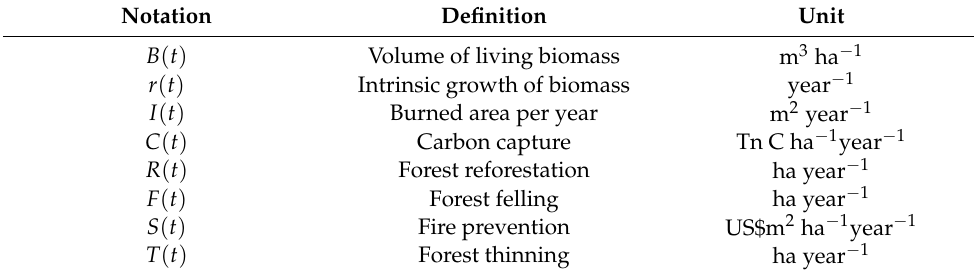
Table 1. Notation, definition, and units of each